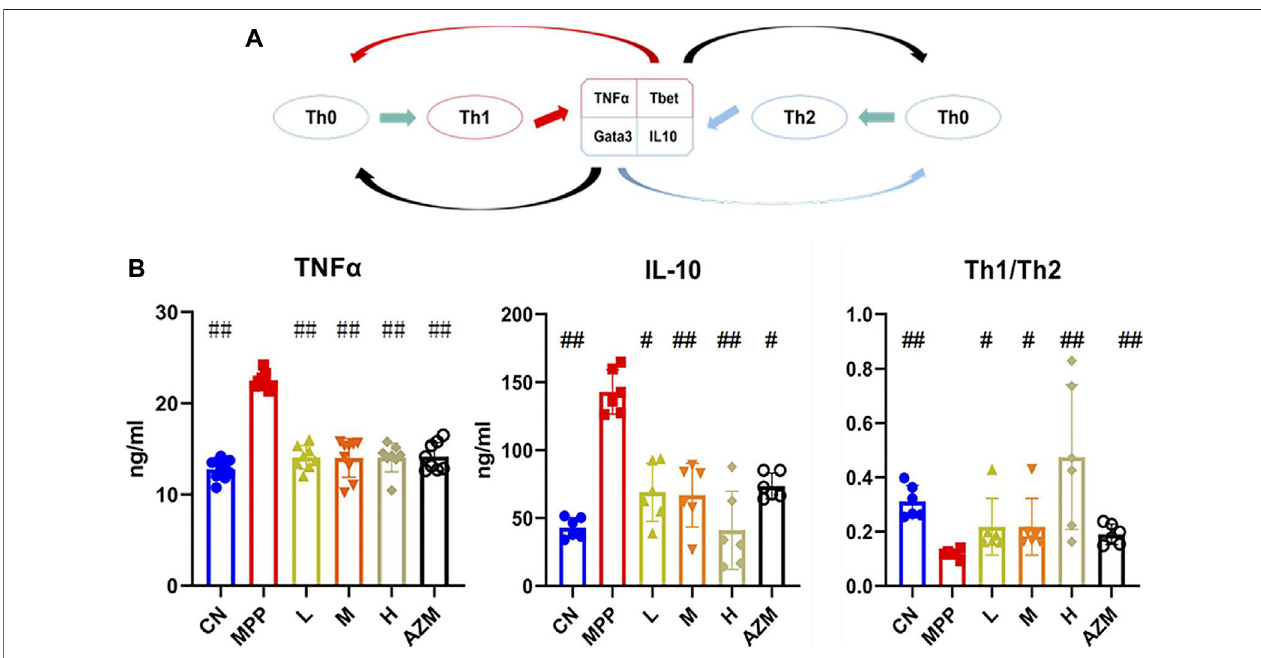
FIGURE 3 | (A) T-cell differentiation diagram, the black arrow indicates inhibition and the remaining arrows indicate promotion. (B) Serum TNF- α and IL-10 expression levels, and the Th1/Th2 ratio. The signi fi cant differencewas calculated using analysis of variance, # p < 0.05, ## p < 0.01 and compared with the MPP